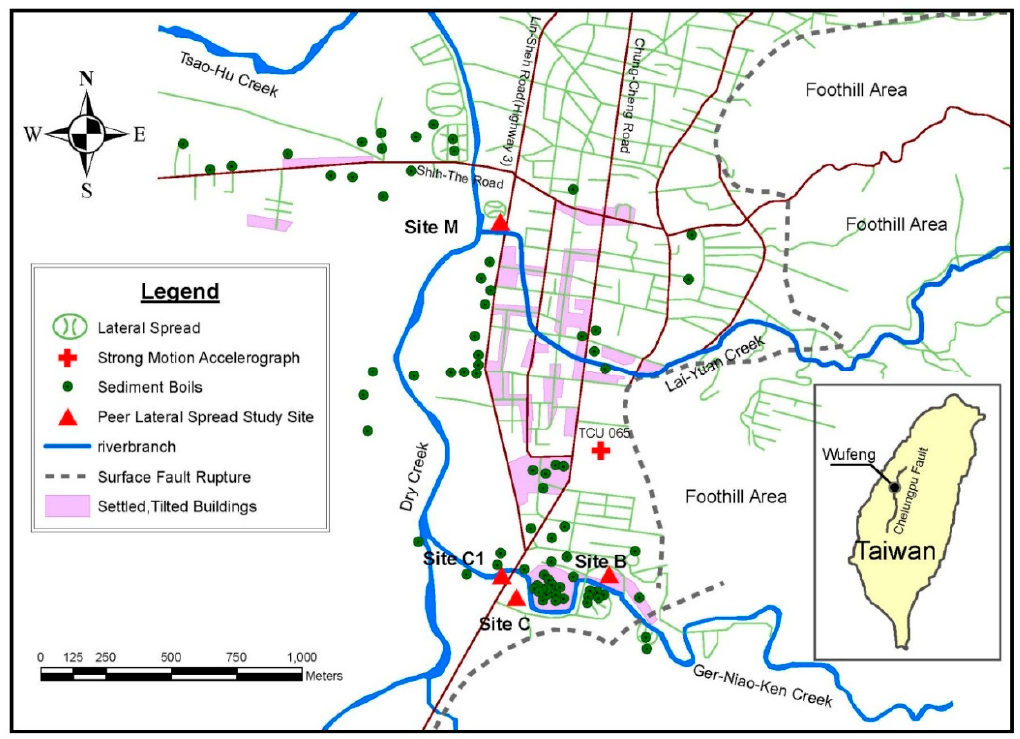
Figure 1. Location of lateral displacement and ground failure due to liquefaction during the Chi-Chi earthquake in the Wufeng district.